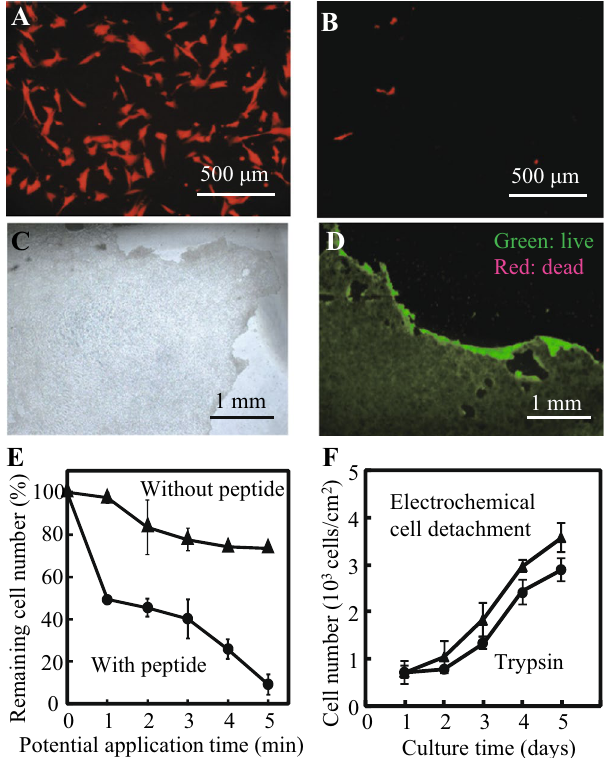
Figure 3. Electrochemical cell detachment from gold substrates prepared with electroless gold plating. ( A , B ) Fluorescent images of RFP-HNDFs on the gold substrates modified with oligopeptide before ( A ) and after ( B ) potential application. ( C ) Phase-contrast microscopic image of detached NB1RGB cell sheet. ( D ) Live/dead staining of cells in the detached cell sheet. The cytoplasm of viable cells is green, whereas the nuclei of dead cells are red. ( E ) Changes in the number of cells remaining on the gold substrates after potential application with/ without oligopeptide modification. The error bars indicate standard deviations calculated from 3 independent experiments. ( F ) Proliferation of electrochemically detached cells on a conventional culture dish. Cells were collected using potential application for 5 min or trypsin treatment and then seeded on a conventional culture dish. The number of cells were counted on fluorescent microscopic images. The error bars indicate standard deviations calculated from 3 independent